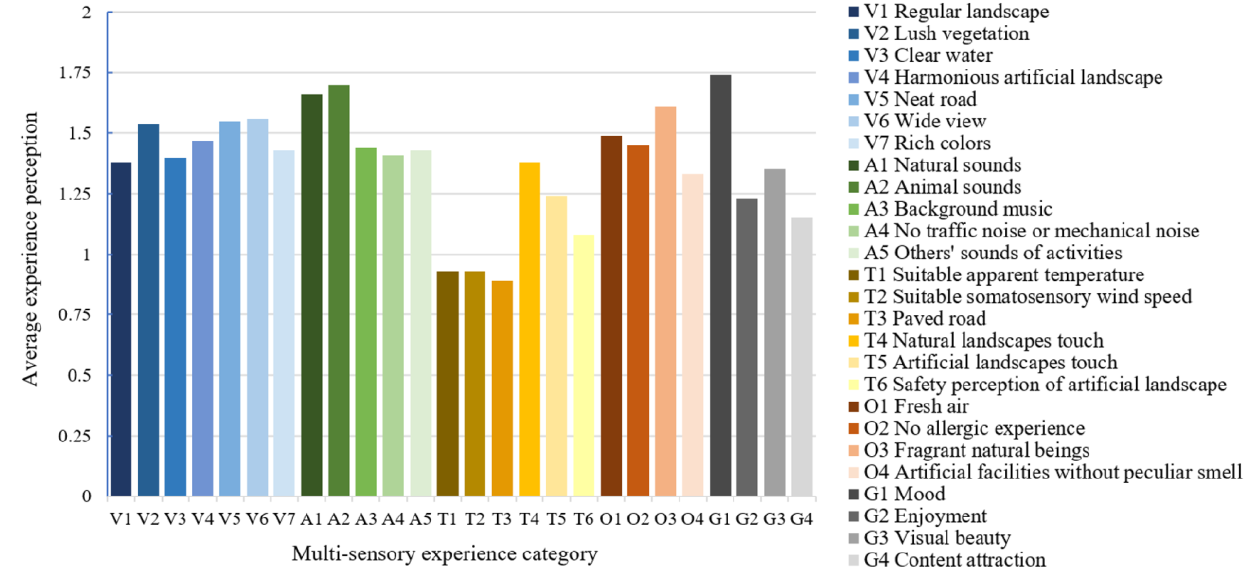
Figure 7. Bar chart of perceived mean values of children’s multi-sensory experiences in an urban forest park (more details of items are shown in Table 3). Table 3. Descriptive analysis of the perception of multi-sensory experiences in the urban forest park ( n = 336).